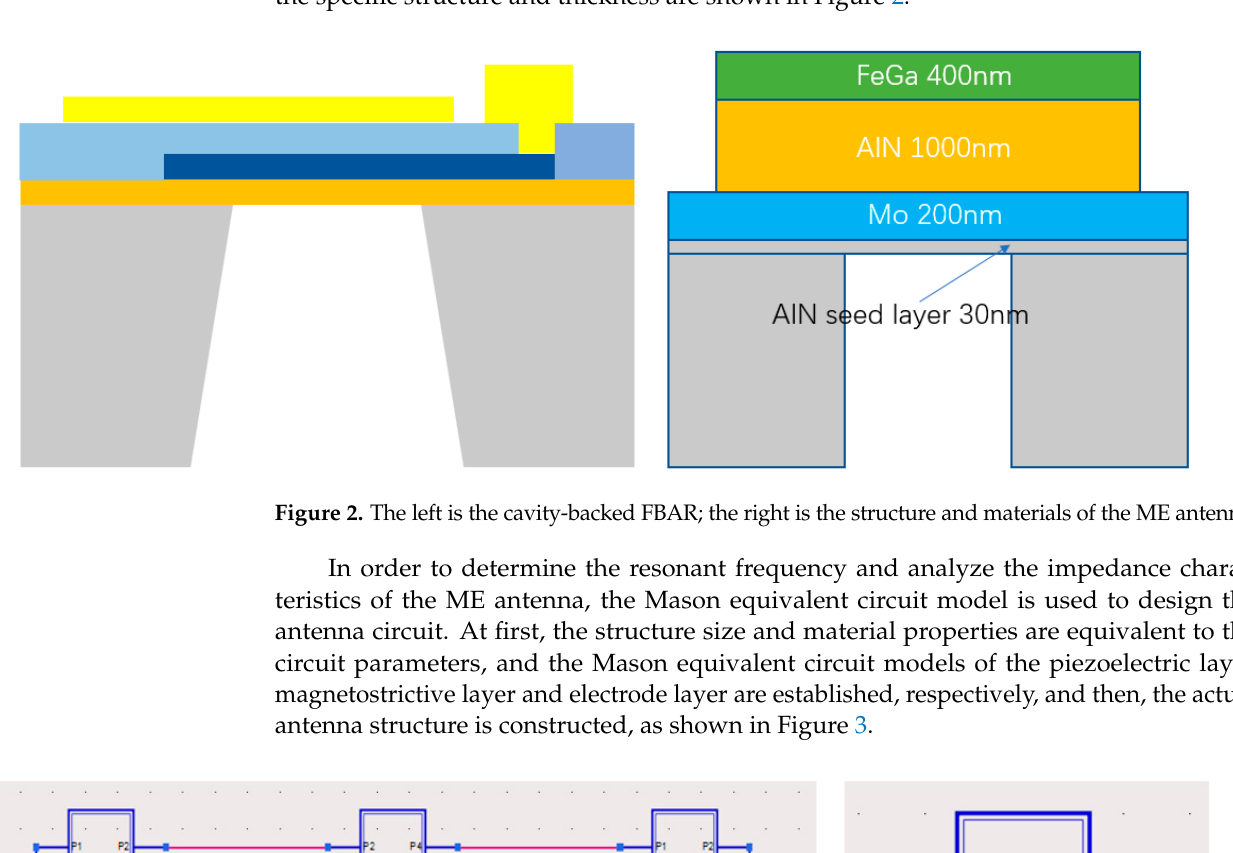
Figure 2. The left is the cavity-backed FBAR; the right is the structure and materials of the ME antenna.